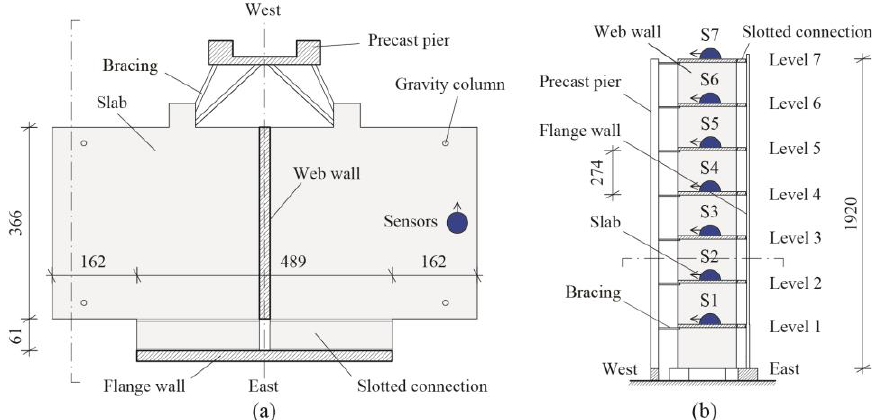
Figure 2. Structural scheme and location of sensors considered in this study in ( a ) plan view and ( b ) lateral view (Adapted with permission from Ref. [27]. Copyright 2021 Elsevier.). Measures are in cm.